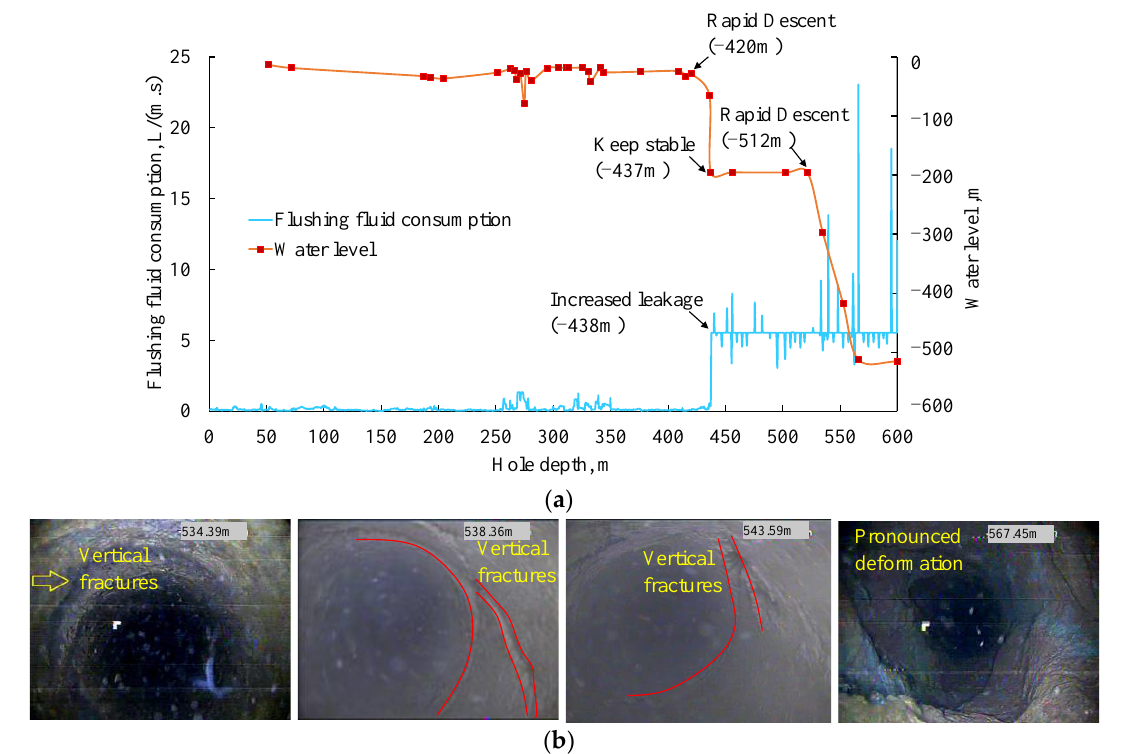
Figure 9. In situ detection result at No. Y3 borehole. ( a ) Flushing fluid and bore water level variation, and ( b ) borehole camera.